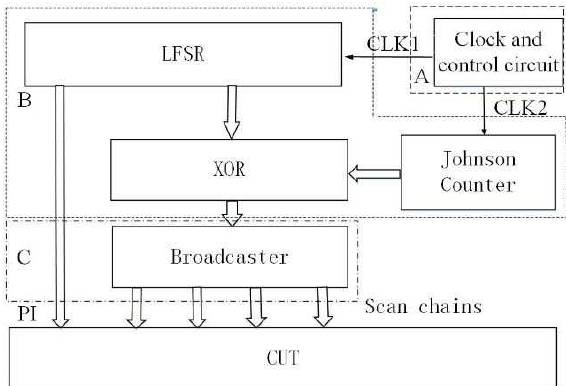
Figure 1. Broadcast-based multiple single input charge (BMSIC)-TPG